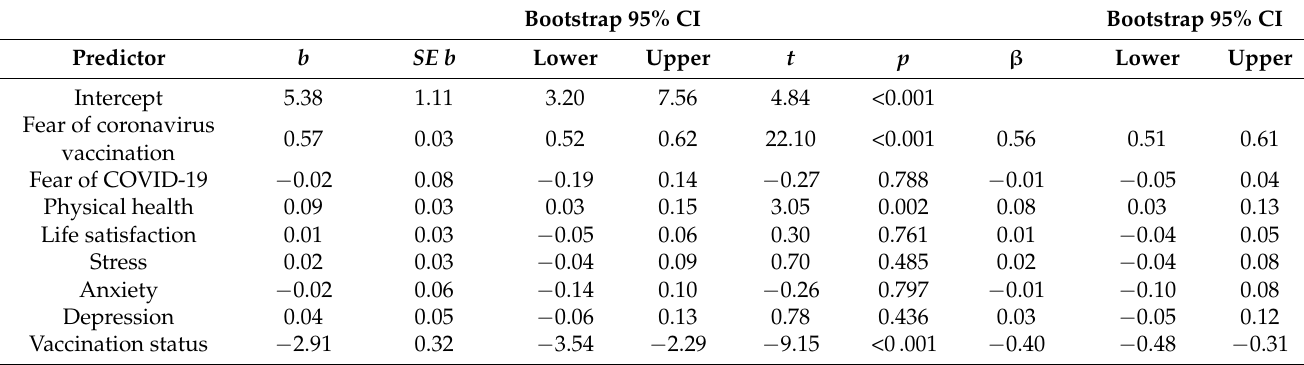
Table 6. Multiple linear regression for fear of coronavirus vaccination ( N =